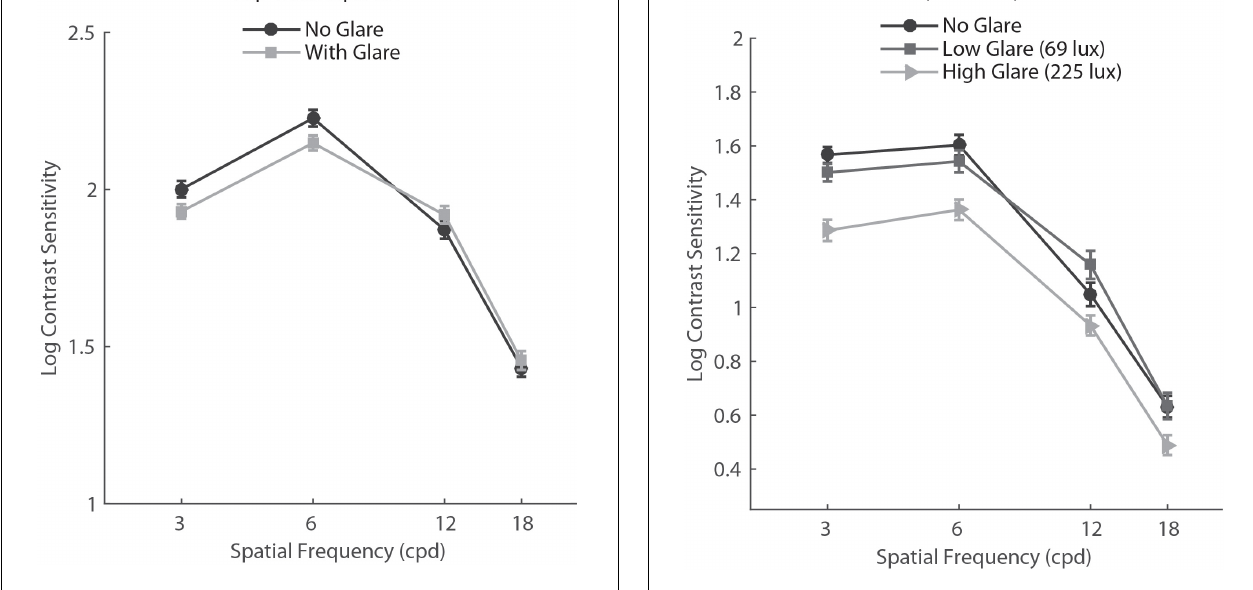
FIGURE 3 | Contrast sensitivity function in mesopic light condition for no glare, low glare (69 lux), and high glare (228 lux) levels, tested with the custom-built setup. Error bars represent standard